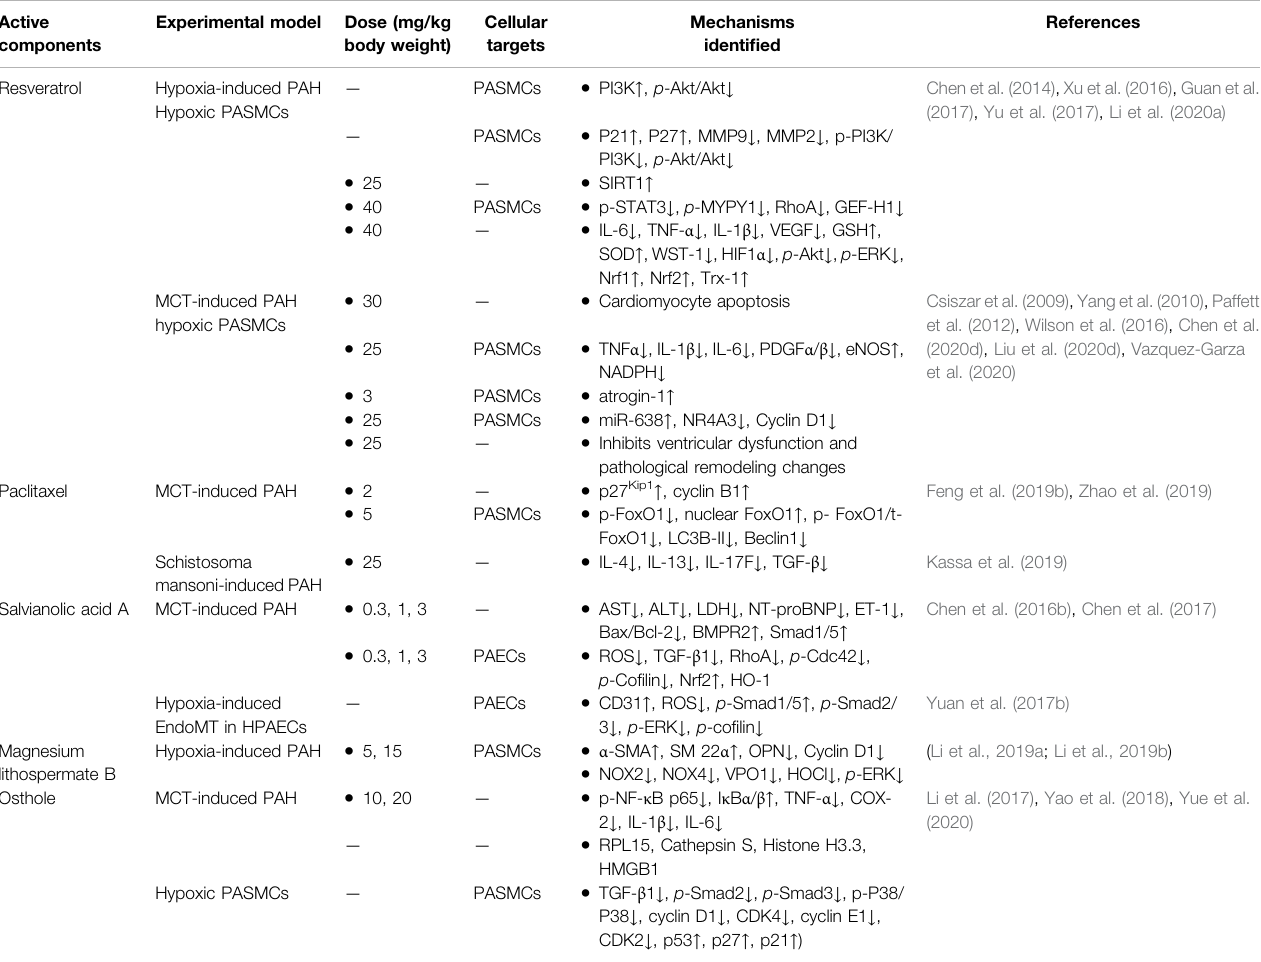
TABLE 5 | Phenolic acids as THM-derived active components for PAH treatment. Active